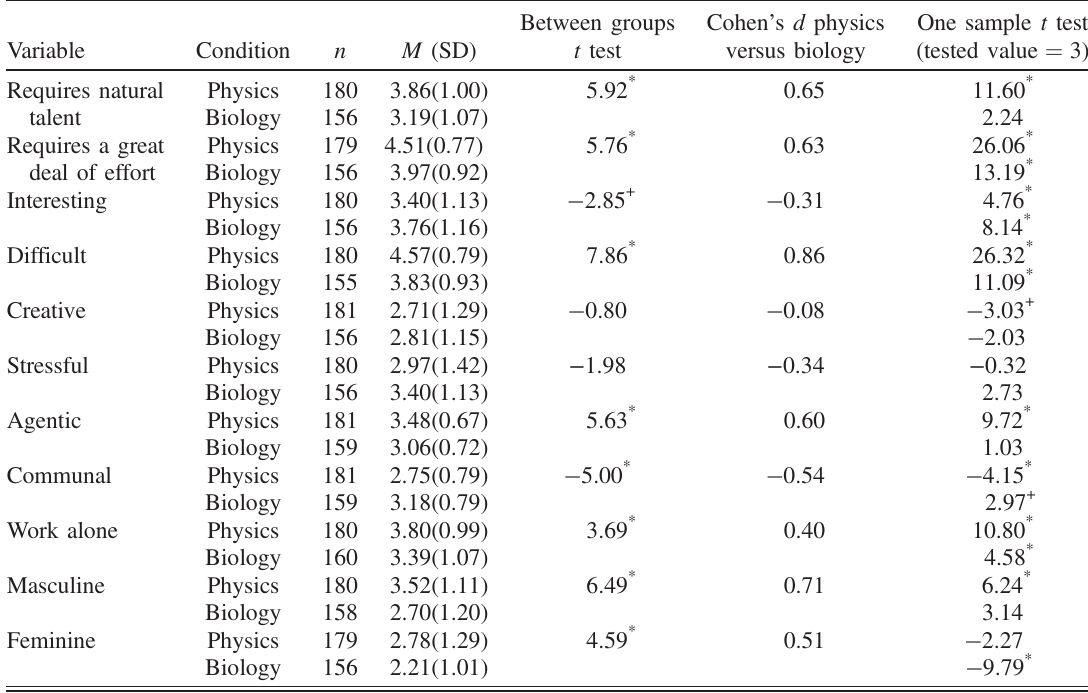
TABLE III. Descriptive statistics and t -test values for field characteristics of physics and biology. Variable